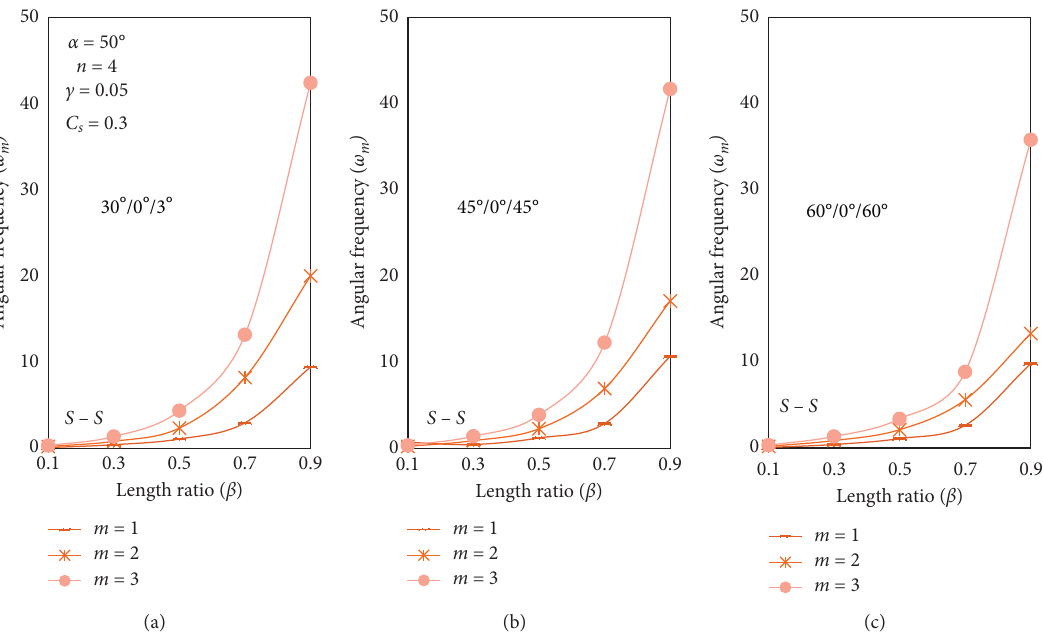
Figure 3: Influence of length ratio on the angular frequency of three-layered conical shells with GE/EGE/GE material Figure 12 depicts the fundamental angular frequency variation with respect to length ratio for three-layered shells under C-F boundary conditions. The characteristic pattern of curve is similar to that in Figure 10, whereas the frequency value decreases under C-F boundary condition as compared to S-S boundary condition.